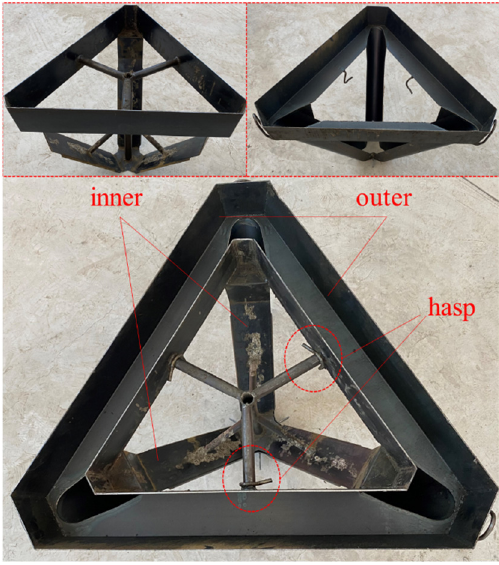
Figure 2. Composite steel mold of pervious frame.